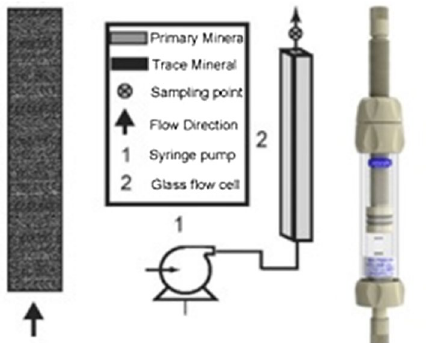
Fig. 1 Flow cell